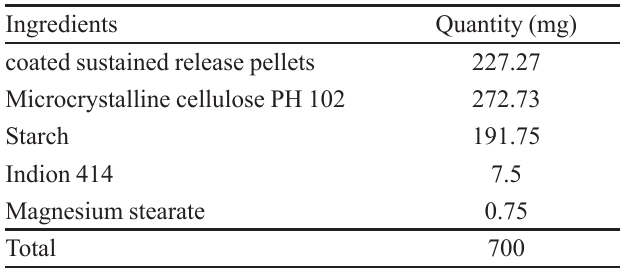
TABLE IV - Composition of multiparticulate sustained release